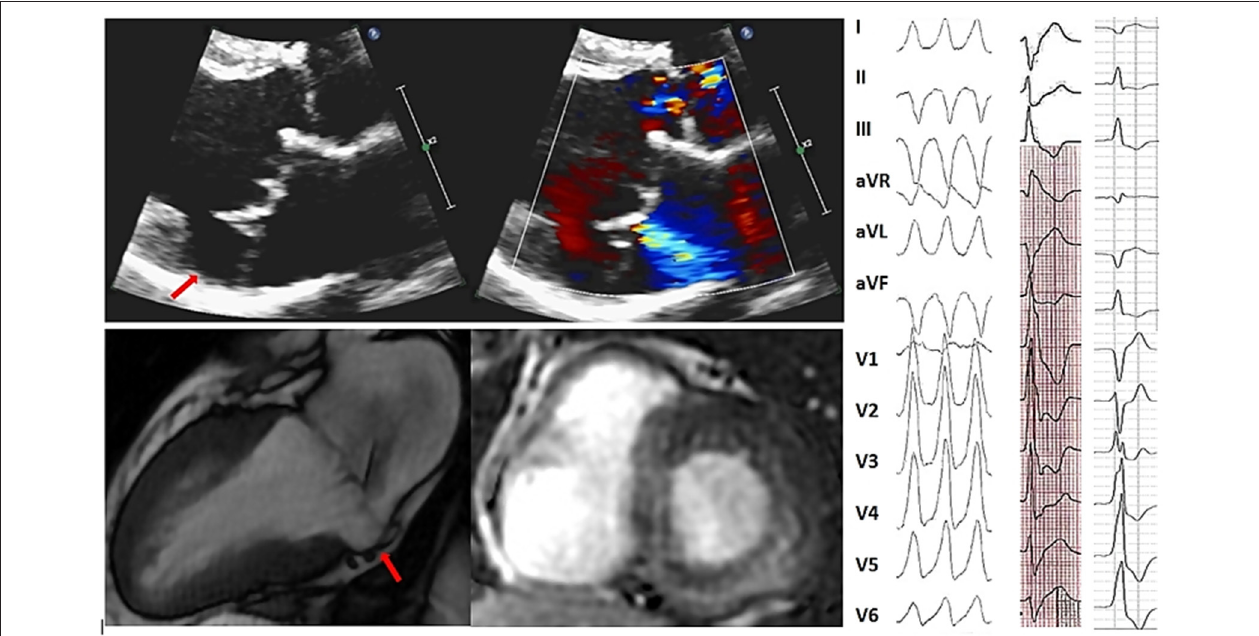
FIGURE 1 | Representative of bileaflet mitral valve thickening and prolapse coexisting with mitral annular disjunction and myocardial arrhythmogenic substrate and 12-lead surface ECG illustrating multifocal ventricular arrhythmias in the same patient. Sixty-nine year old man without history of coronary artery disease referred for work-up of episodes of syncope. Bidimensional echocardiography, parasternal long-axis view at end-systole (upper panels) showed a bileaflet mitral valve thickening and annular disjunction (red arrow). Doppler evaluation showed a mild mitral regurgitation due to a bileaflet myxomatous mitral valve prolapse. Cardiac MRI cine imaging in two-chamber view (right bottom) identified a 11mm large mitral annular disjunction localized to the posterior left ventricular wall and basal short-axis late gadolinium—enhanced (LGE) cardiac MRI (middle bottom) demonstrated midwall LGE most prominent at basal inferior and inferoseptal wall consistent with intramural myocardial fibrosis. Sustained monomophic ventricular tachycardia (on the right) with a right bundle branch block and superior axis coresponding to the posterobasal left ventricular wall origin was induced at the time of electrophysiology study with programmed electrical stimulation. Frequent multifocal premature ventricular complexes of two different morphologies were also recorded: the first one manifesting right bundle branch block configuration, V5 transition and D2/D3 negative/positive discordance pointing toward the anterolateral papillary muscle and the second one with left bundle branch block morphology, V3 transition and inferior axis consistent with an outflow tract